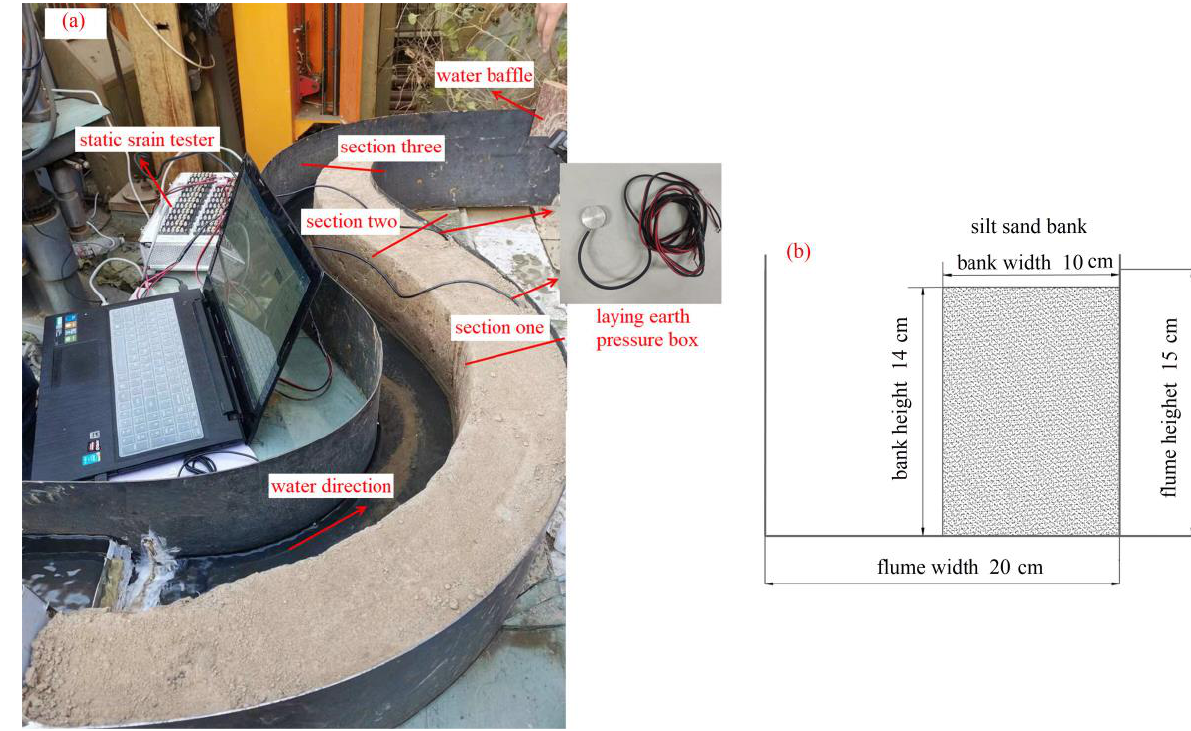
Figure 3. Actual diagram of the scouring experiment: ( a ) the layout of the scouring experiment; ( b ) side views of the flume.